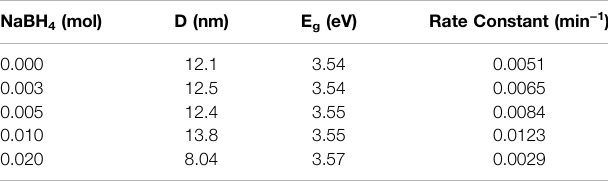
TABLE 4 | The kinetic curves for the degradation of RhB dye by ZnS prepared using different amounts of NaBH 4